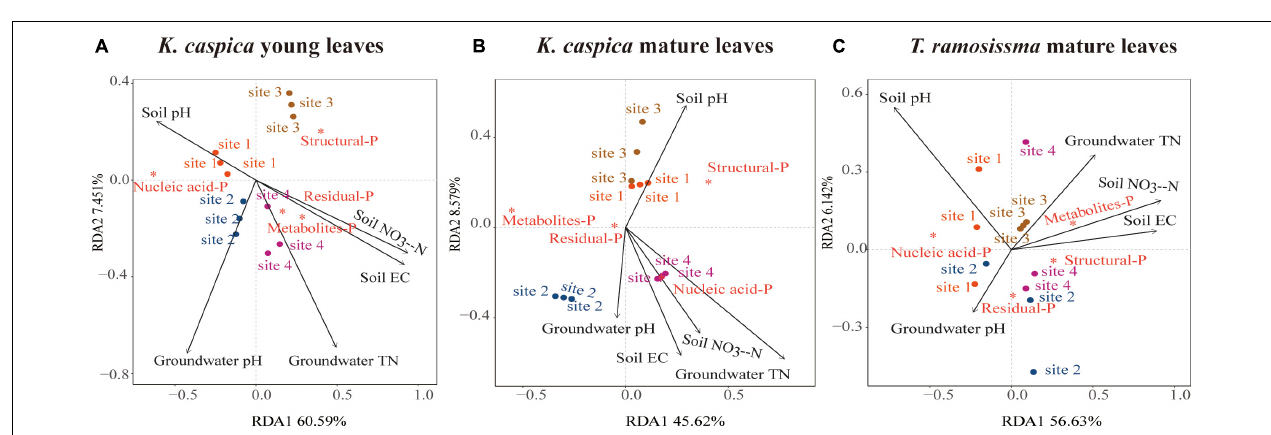
FIGURE 6 | Redundancy analyses of the correlations between foliar-P fractions and soil and groundwater properties. Redundancy analysis on the correlations between soil and groundwater properties and foliar-P fractions of K. caspia young leaves (A) , K. caspia mature leaves (B) , and T. ramosissima mature leaves (C) , respectively. Red asterisk means the foliar-P fractions; black arrow means the soil and groundwater properties. Only the top five environment factors are